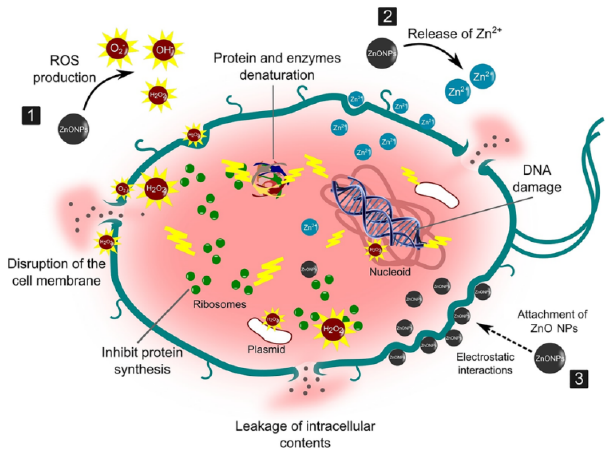
Figure 1. Illustration of the antimicrobial property of ZnO − NPs against the bacterial cell wall. They act as potent antibacterial agents through these possible steps: (1) production of reactive oxygen species (ROS) causing oxidative stress, and membrane and DNA damage leading to bacterial death; (2) dissolution of ZnO − NPs into Zn 2+ and interference with bacterial enzymes, proteins, and amino acids; and (3) electrostatic interaction between ZnO − NPs and cell membrane, resulting in membrane plasma damage and intracellular content leakage. (Reprinted from [29]; open access under CC BY).